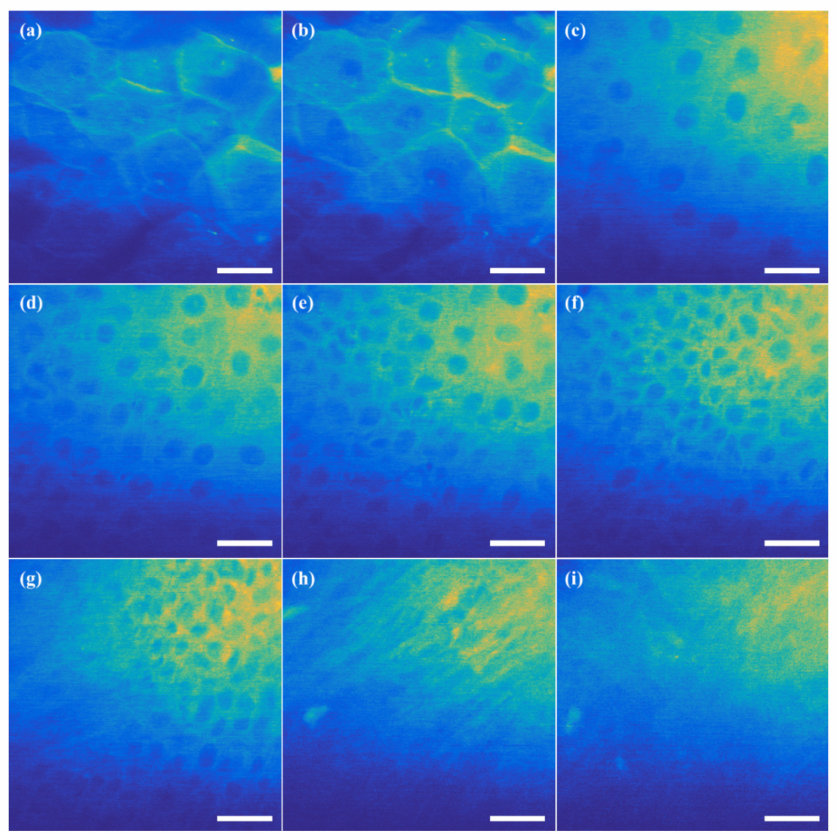
Figure 10. The images of the human skin tissue at different depths from the surface: ( a ) stratum corneum without nuclei at 17 µ m, ( b ) epidermal cells with nuclei 17 µ m, ( c ) granular layer at 45 µ m, ( d ) cell membranes at 54 µ m, ( e ) stratum spinosum at 60 µ m, ( f ) cubic basal cells at 66 µ m, ( g ) dermal fibrous tissue at 76 µ m, ( h ) collagenous fiber tissue at 82 µ m, and ( i ) amorphous collagen tissue at 96 µ m (scale bar: 20 µ